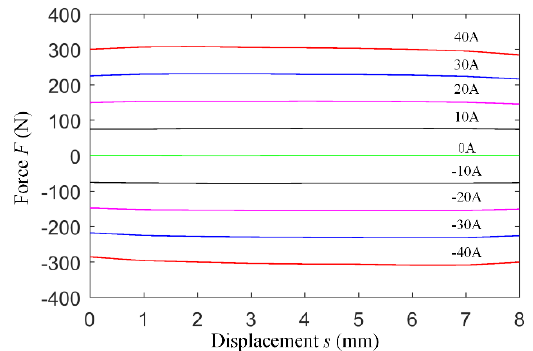
Figure 3. Electromagnetic force characteristic curve of the EMLA.